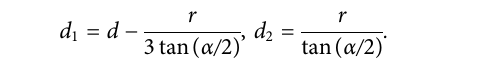
Frontiers in Energy Research |